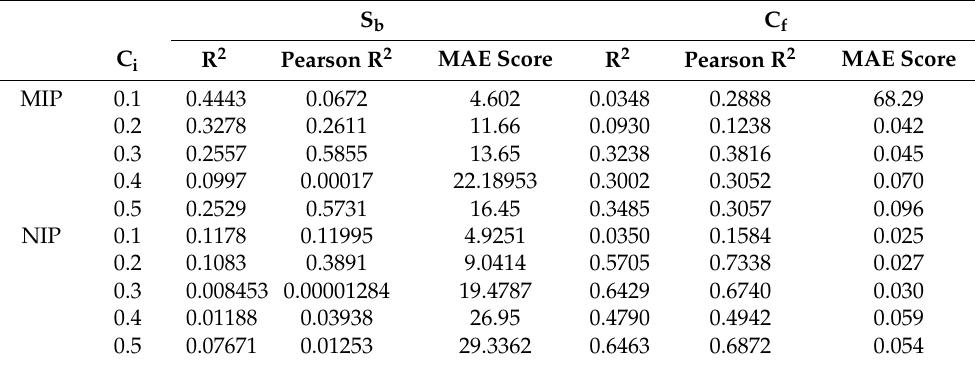
Table 10. Analysis of the error and correlation of the test datasets at a given C i value for the ChemCeption model with SMILESToImage